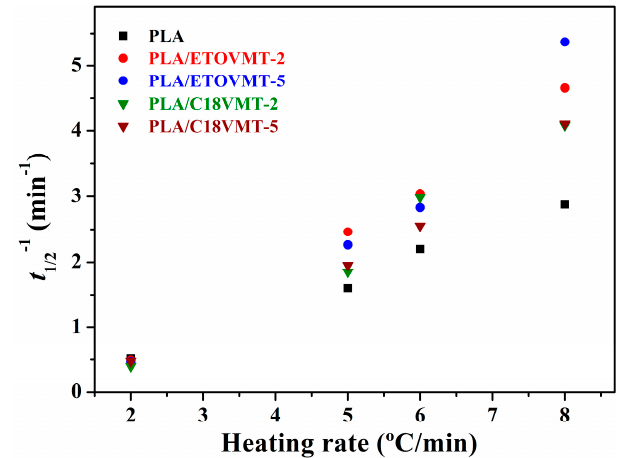
Figure 7. Reciprocal half-time of crystallization at different cooling rates for PLA and PLA/VMT nanocomposites.